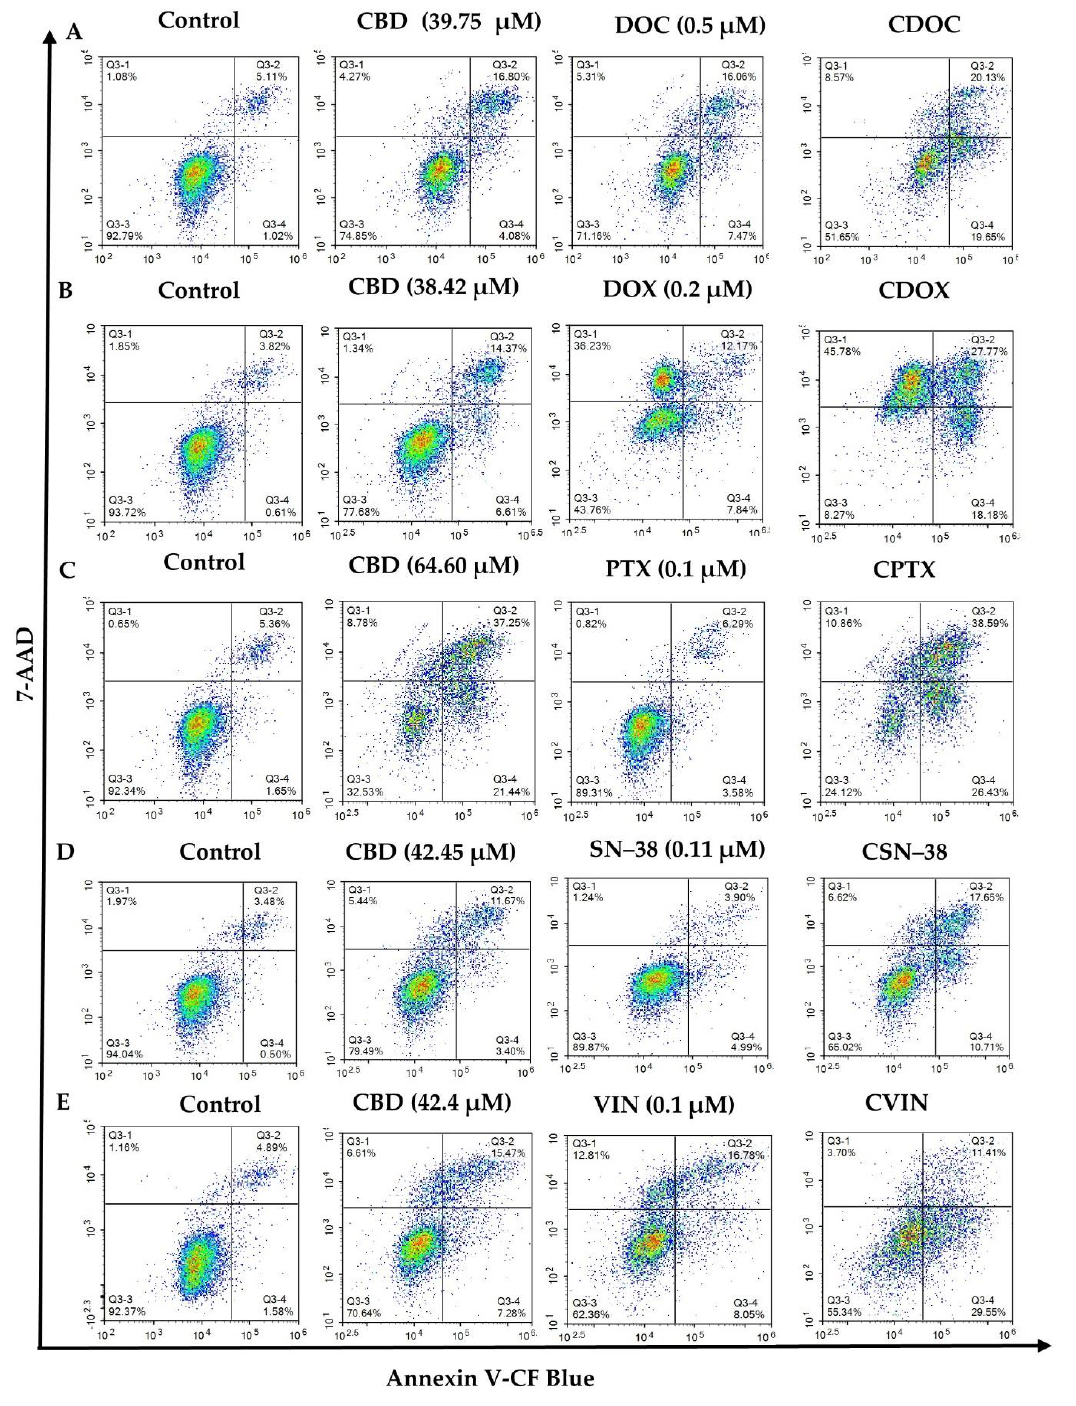
Figure 4. Flow cytometric assessment of the apoptotic profiles of MCF7 cells after 24 h of treatment with cannabidiol, chemotherapeutic drugs, and their synergistic combinations ( A–E ). The images are representative of three separate experiments. CBD = cannabidiol: DOC = docetaxel: DOX = doxorubicin: PTX = paclitaxel: SN − 38: VIN = vinorelbine. ( A ) CDOC = CBD + DOC, ( B ) CDOX = CBD + DOX, ( C ) CPTX = CBD + PTX, ( D ) CSN–38 = CBD + SN–38, ( E ) CVIN = CBD + VIN. Cells were treated with the monotherapies, combinations, and vehicle control (0.5% DMSO), and detected using antibodies against Annexin V-CF Blue and the reporter 7AAD after 24 h of treatment. Raw data are available in Table